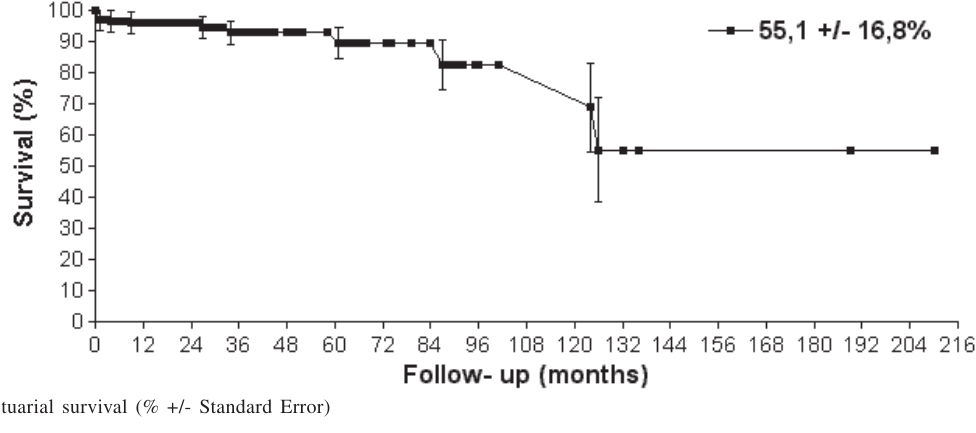
Figure 2 - Actuarial survival (% +/- Standard